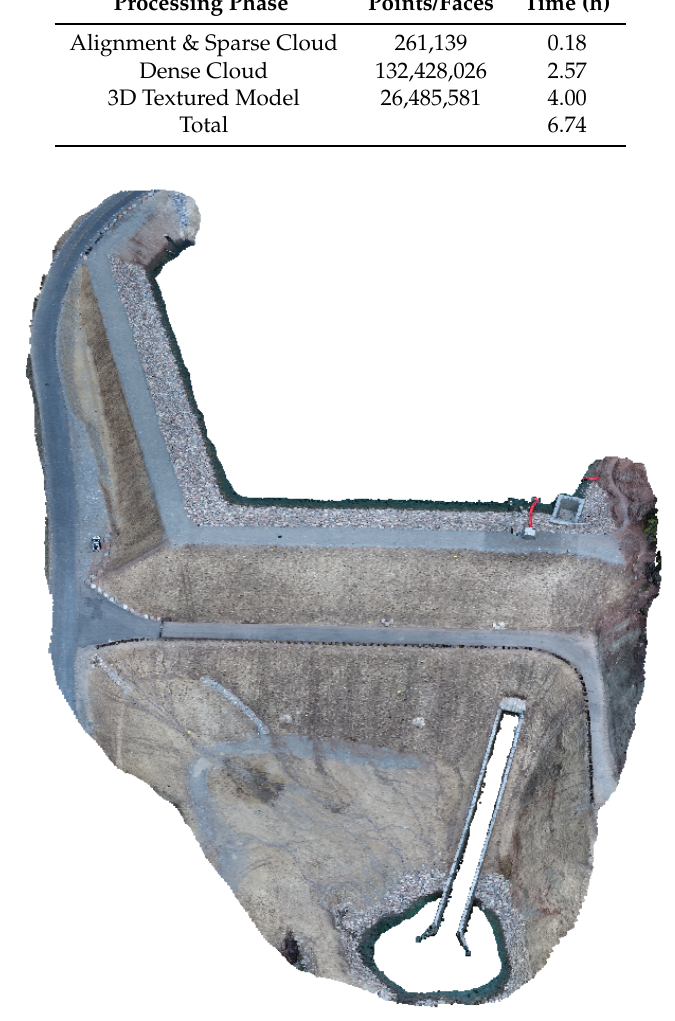
Figure 9. Final model of Tibble Fork Dam built using Agisoft PhotoScan software.